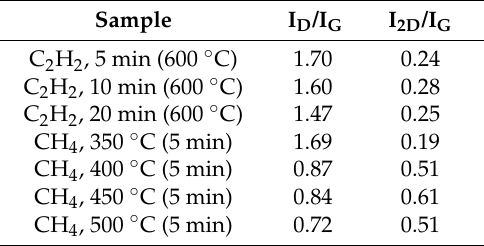
Figure 3 indicates the potentiodynamic polarization curves of the first scan for pure, CVD graphene (C 2 H 2 , 5 min)-coated, and CVD graphene (CH 4 , 350 ◦ C)-coated Cu foils. The experiments were carried out ranging from − 0.8 V to 0.6 V v.s. Ag/AgCl at the scan rate of 10 mV/s at room